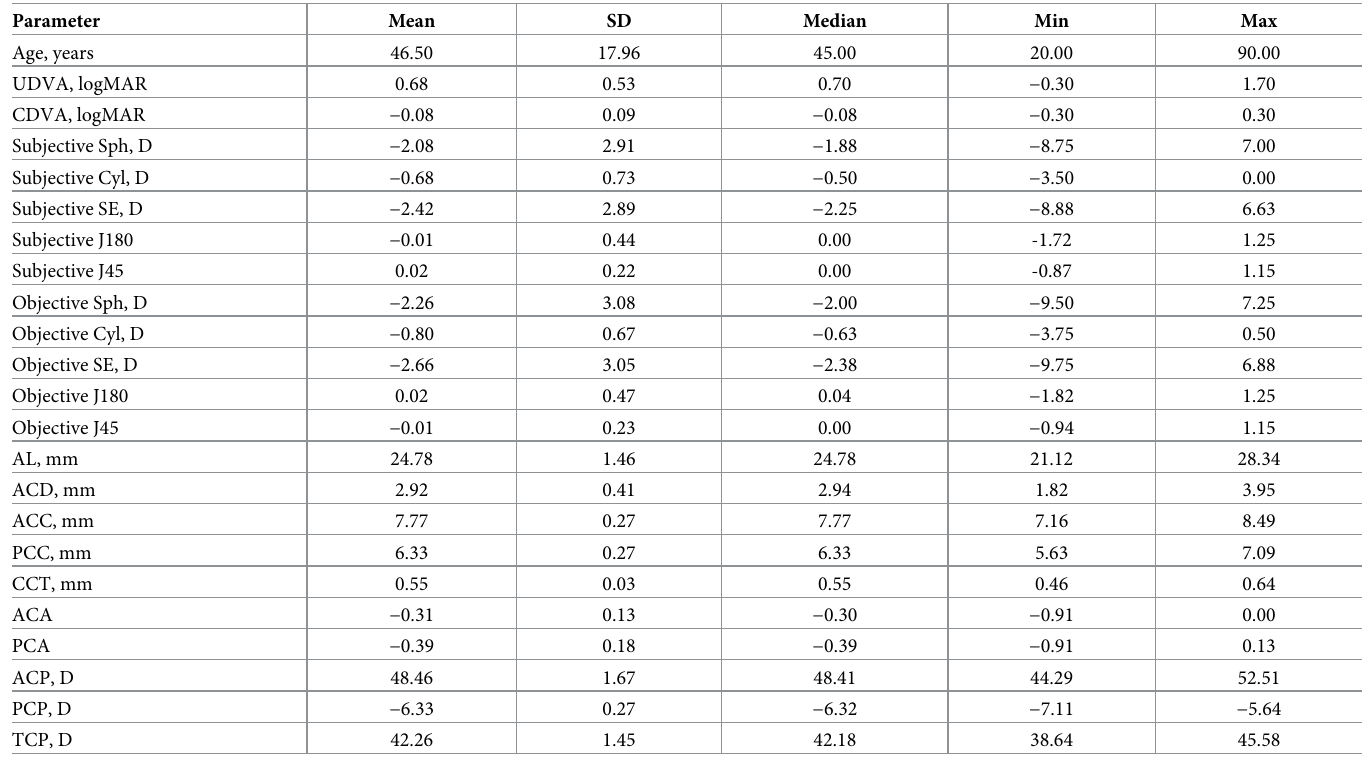
Table 1. Descriptive statistics (n =